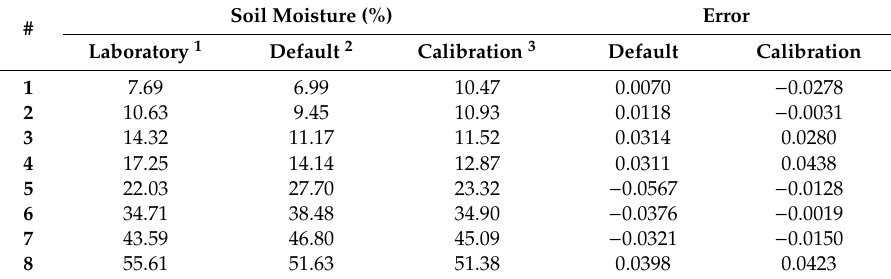
Table 4. Laboratory measurements, sensor readings and errors of Calibration Group